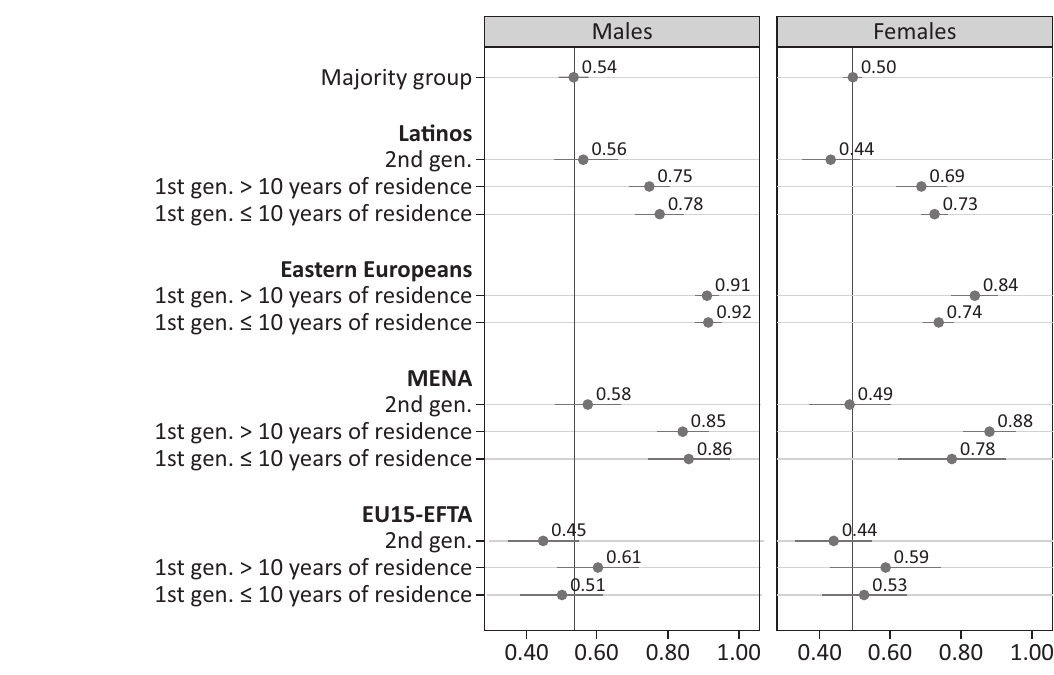
Figure 3. Predicted probabilities of over-education for first- and second-generation, by gender (pooled data). Notes: Con- trols for age, year, civil status, dependent children and degree of urbanisation; the category “Eastern Europeans second generation” is omitted given its small size; N = 56,514; only high-skilled migrants aged 16–64, not in education/training or retired; weighted and clustered by